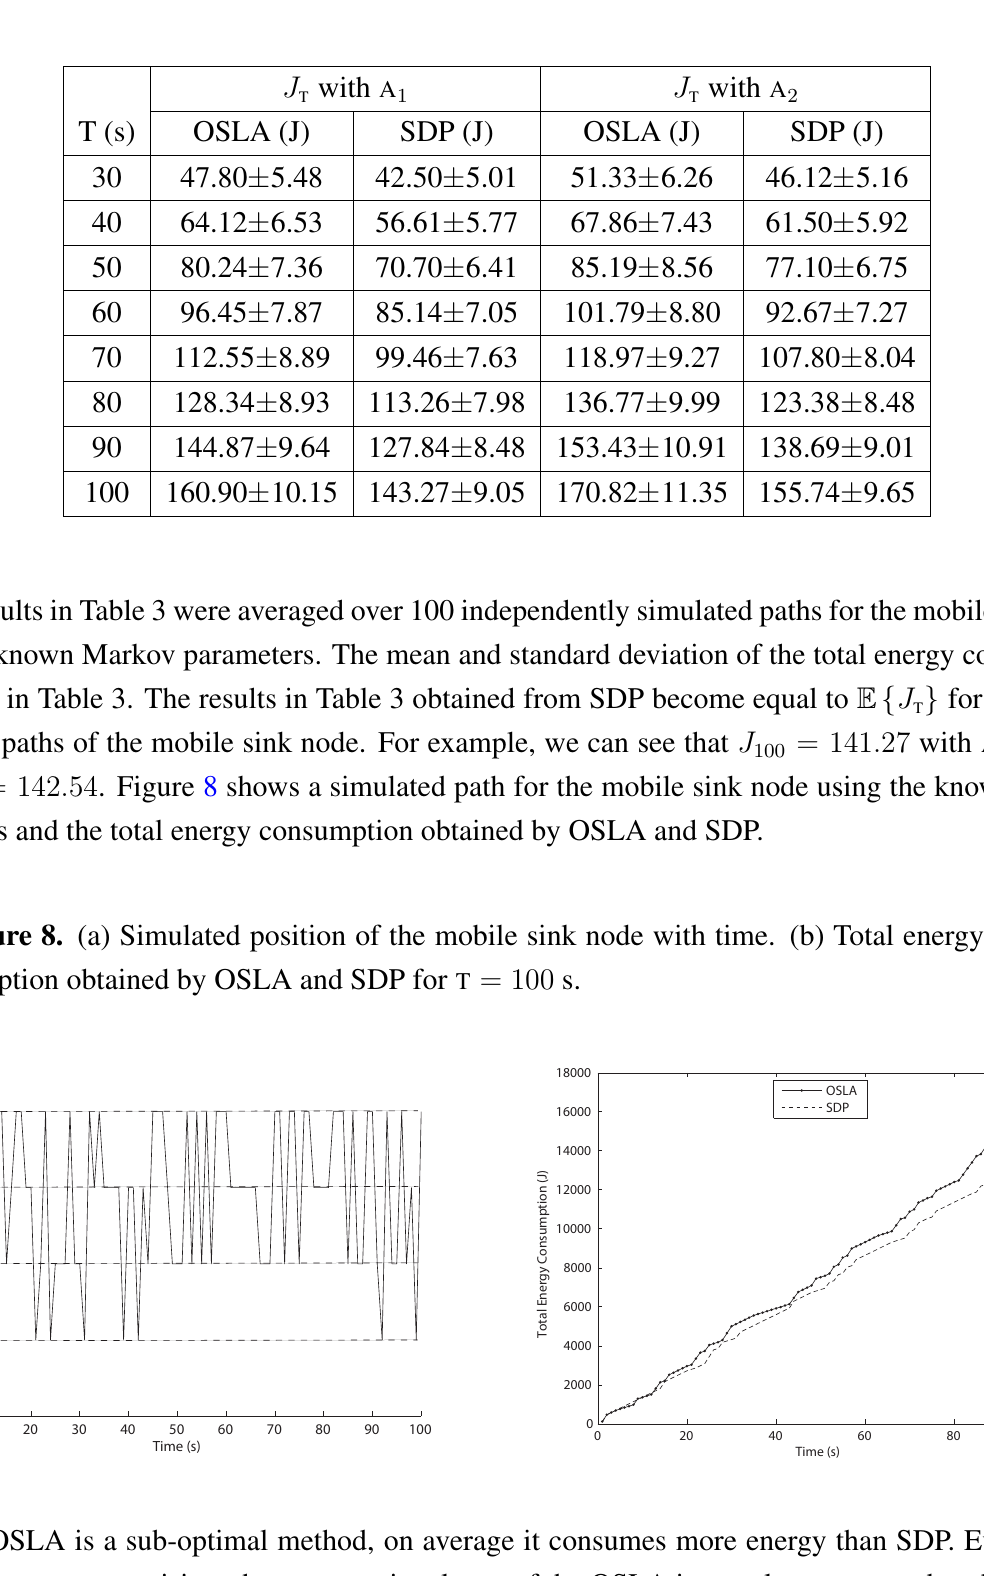
Table 3. Total average energy consumption obtained by OSLA and SDP with different transition matrices.